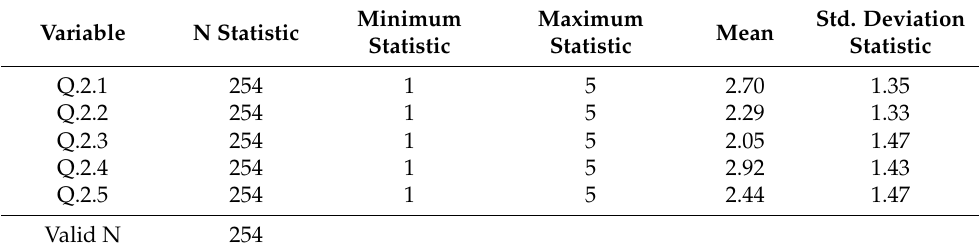
Table 9. Descriptive statistics of entrepreneurial